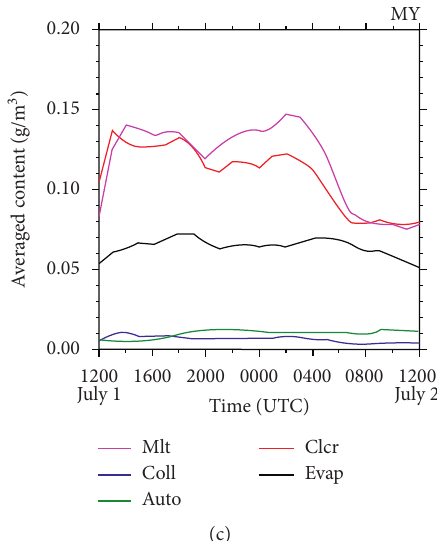
Figure 10: Time series of the mean content of the main sources and sinks of rain in heavy rainfall areas from 1200 UTC on 1 July to 1200 UTC on 2 July in 2016: (a) Morrison, (b) Thompson, and (c) MY.